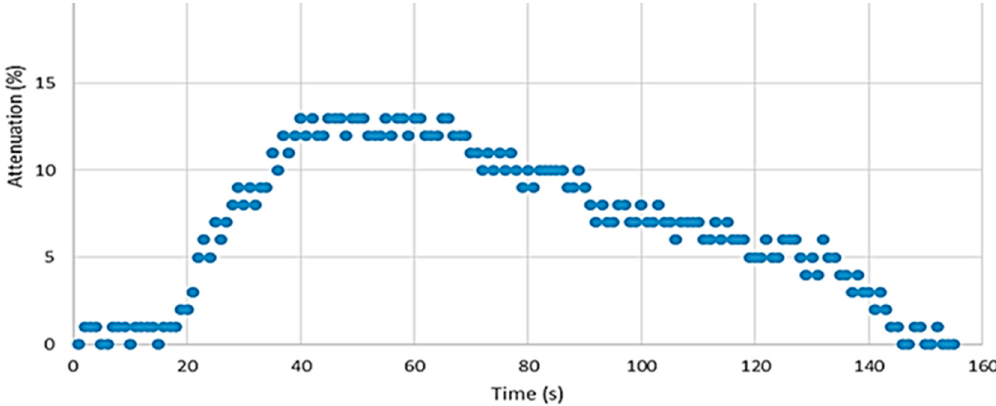
Figure 11. Attenuation of the fluorescence emission of the F8T2 in ethyl cellulose when exposed to NB (1.7 × 10 − 5 M) vapors for 20 s.